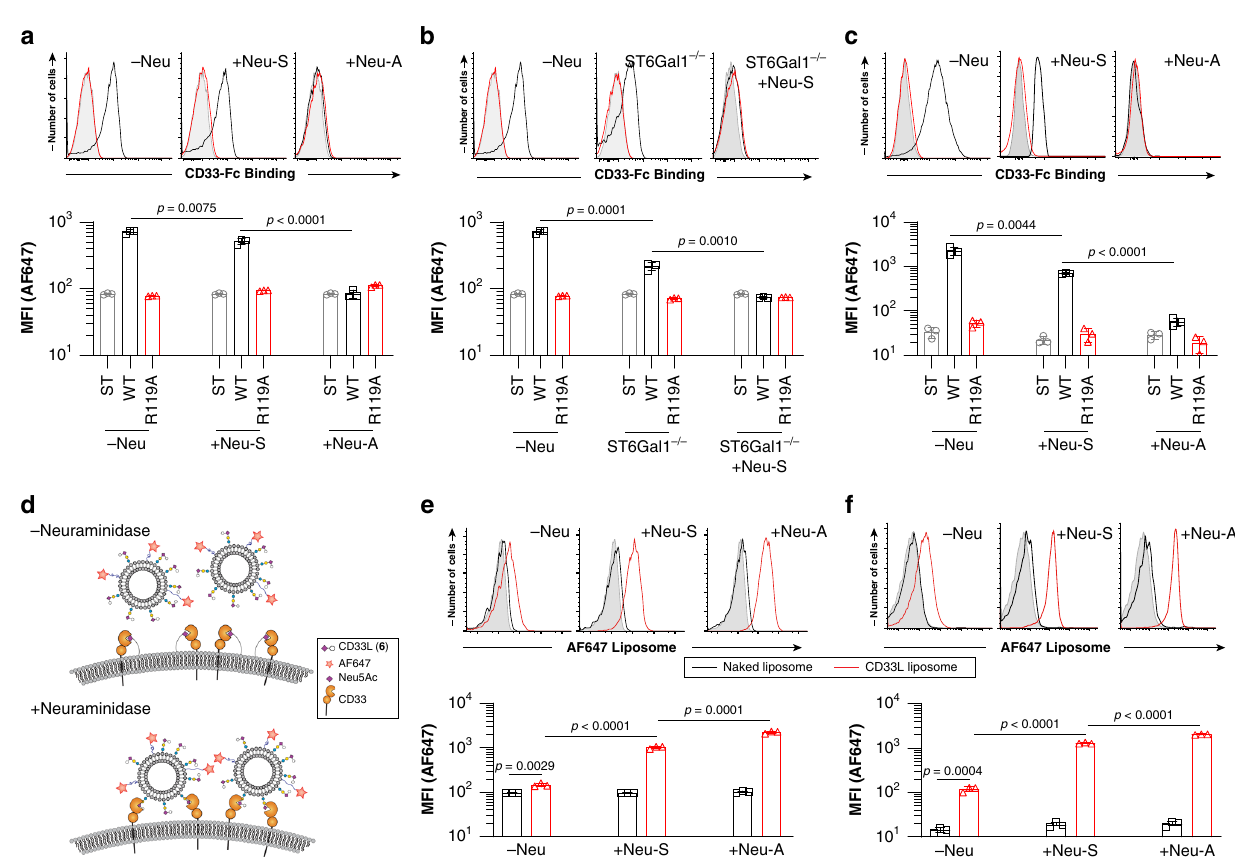
Fig. 6 Cellular ligands of CD33 on human monocytes are both α 2-3 and α 2-6 sialosides. a Staining of U937 cells treated with an α 2-3-speci fi c sialiadase (Neu-S) or broadly acting sialiadase (Neu-A) with CD33-Fc pre-complexed with Strep-Tactin-AF647. b Staining of WT and ST6Gal1 − / − U937 cells with CD33-Fc pre-complexed with Strep-Tactin-AF647. c CD33-Fc binding to human peripheral blood monocytes treated with Neu-S or Neu-A. d Depiction of the unmasking assay performed using CD33 high-af fi nity ligand (CD33L, compound 6) displaying liposomes on WT cells or cells treated with neuraminidase. e , f Binding of CD33 ligand-targeted liposomes (red) or naked liposomes (black) to U937 cells ( e ) or to human peripheral blood monocytes ( f ). Error bars represent ± standard deviation of three replicates. Statistical signi fi cance calculated based on a two-tailed unpaired Student ’ s T